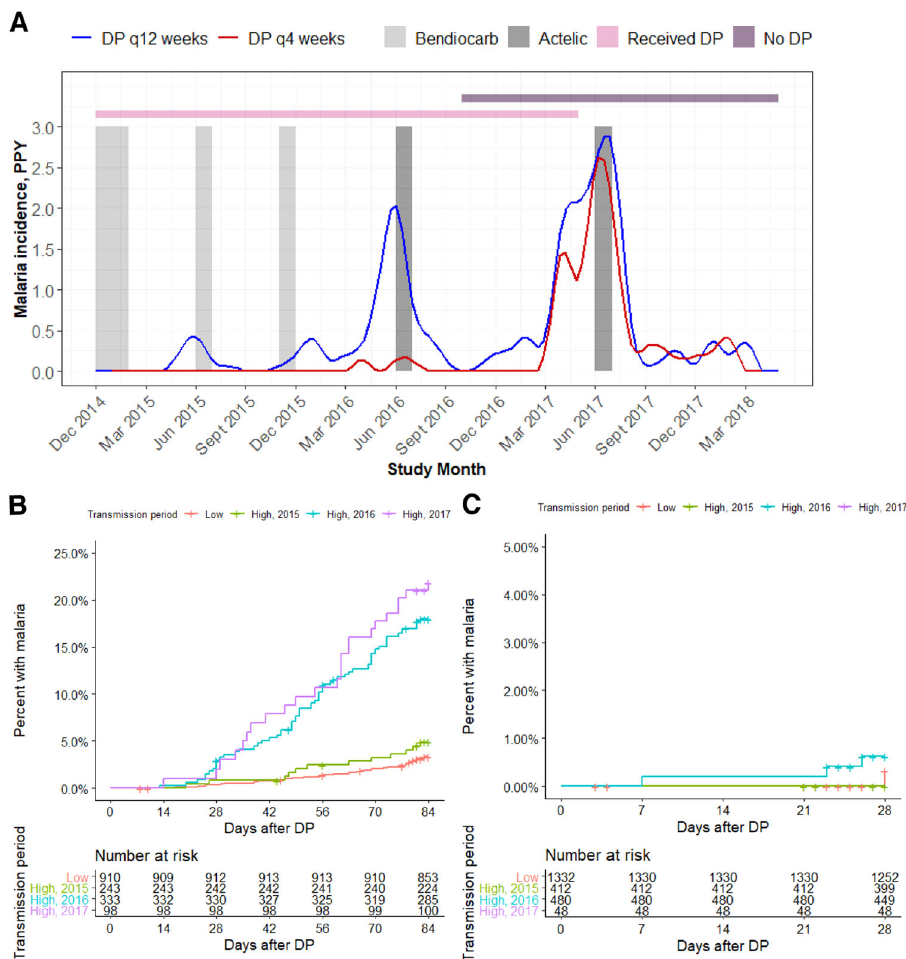
Fig. 4 Malaria outcomes data. A Malaria incidence per person year, strati fi ed by dihydroartemisinin-piperaquine (DP) regimen. The lines indicate malaria incidence for the DP every 12 weeks ( n = 184) (blue) and every 4 weeks ( n = 96) (red) arms. Gray bands indicate periods of indoor residual spraying, and horizontal bars indicate times when participants received DP (pink) or were monitored off DP (purple). As study enrollment occurred over several months, there was a period where part of the cohort was on DP and others had completed the intervention (overlap between pink and purple bars). Time to malaria after receiving DP in the every 12-week arm B and the every 4-week arm C strati fi ed by malaria transmission period. The low transmission periods are combined and the high transmission periods are shown